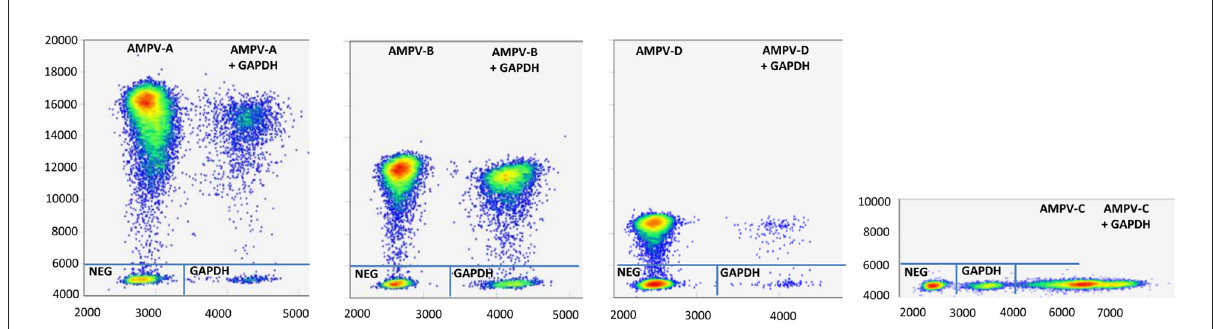
the amplitude values in the CH1 and CH2 channels were calculated. Non-parametric Kruskal-Wallis test was applied to confirm statistical differences between the amplitude values of the different